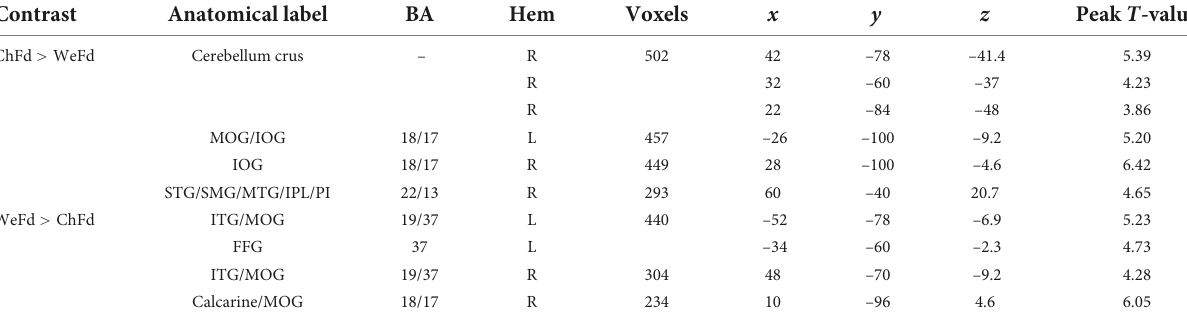
TABLE 3 Activation differences during exposure to Chinese vs. Western food images ( N = 66).